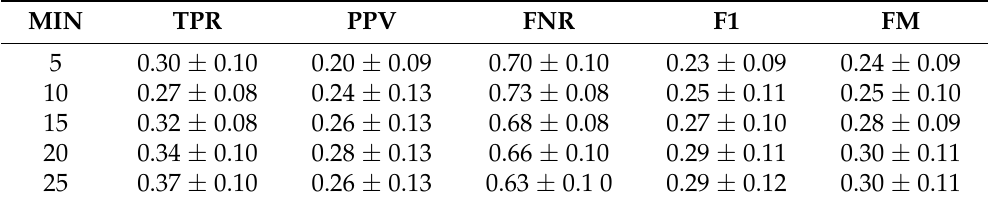
Table 3. Evaluation results of SLAM-OR (YOLO v4) algorithm depending of OPTICS parame- ters setup.